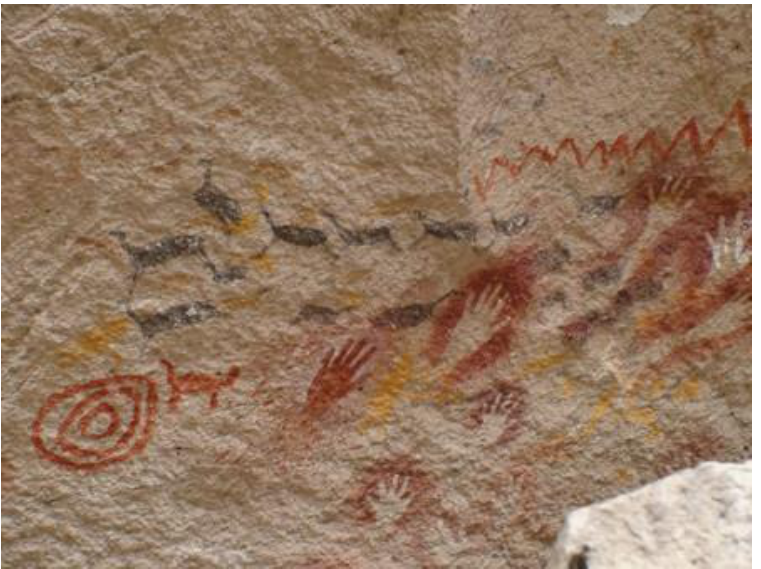
Figure 16. Associated images, Cueva de las Manos, Santa Cruz,